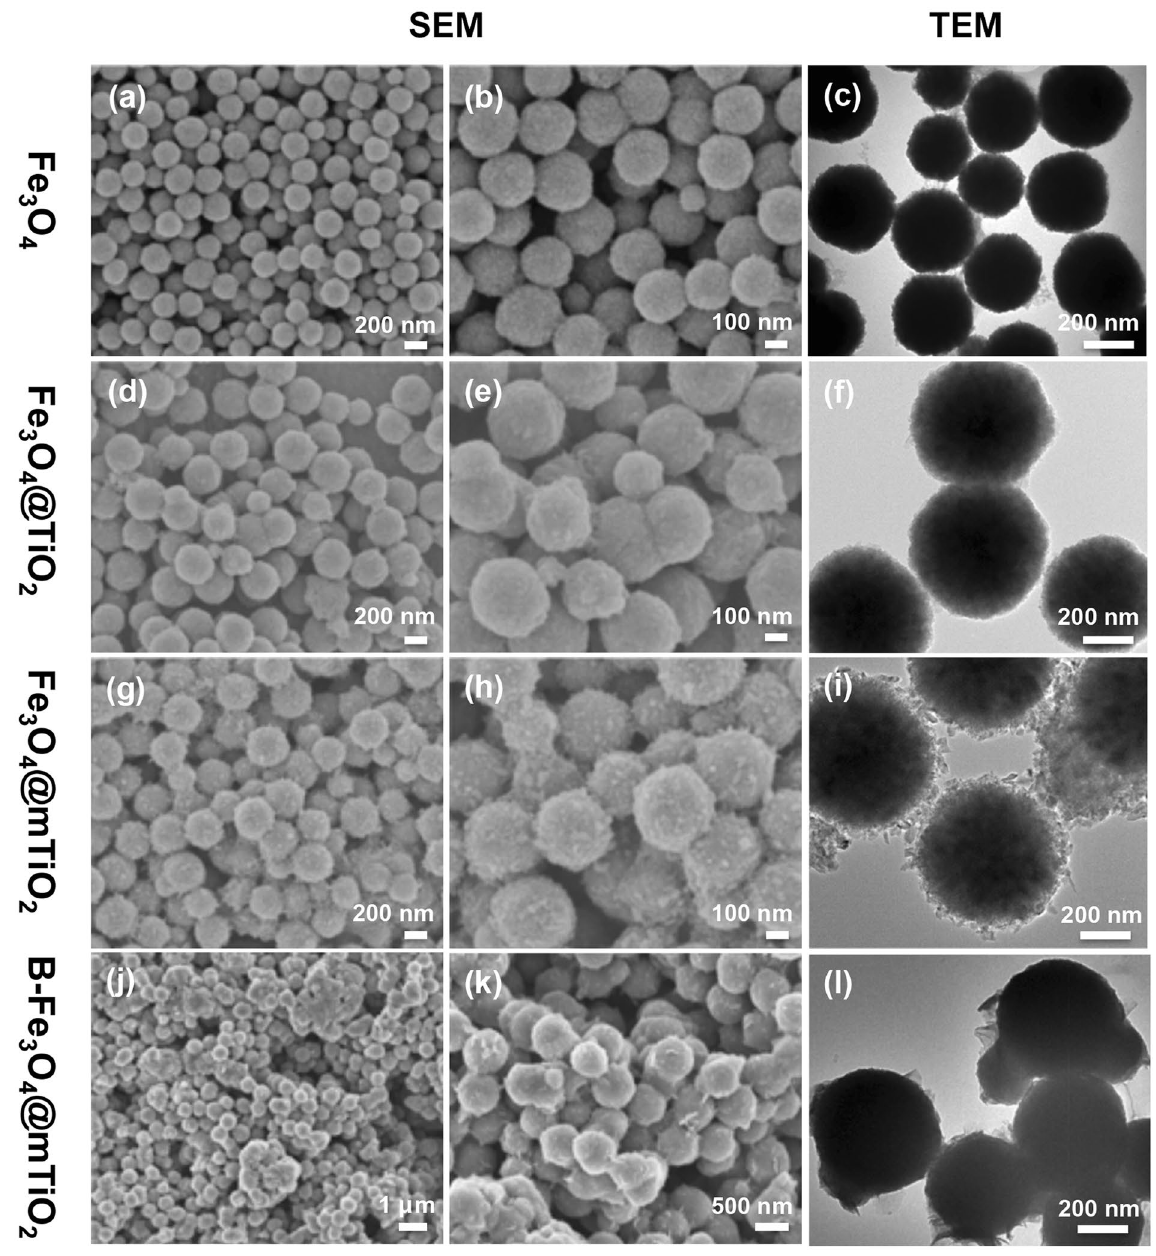
Figure 2. SEM and TEM images ( c,f,i,l ) of Fe 3 O 4 ( a–c ), Fe 3 O 4 @TiO 2 ( d–f ), Fe 3 O 4 @mTiO 2 ( g–i ), and B-Fe 3 O 4 @ mTiO 2 particles ( j–l